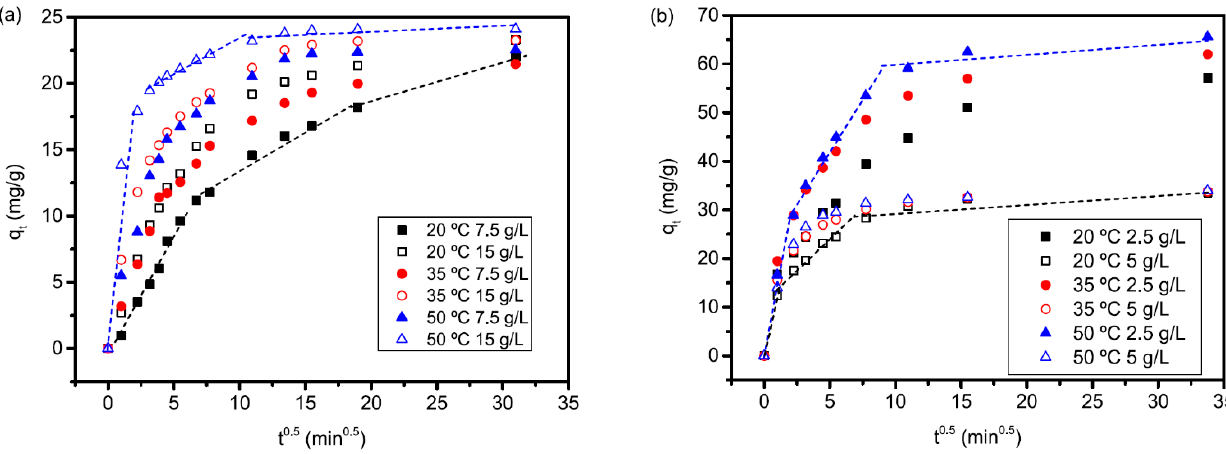
Figure 9. Intra-particle diffusion for ( a ) pseudoboehmite ( b ) γ -Al 2 O 3 (experimental conditions: initial pH 8.5, dosages and temperatures in the legend).